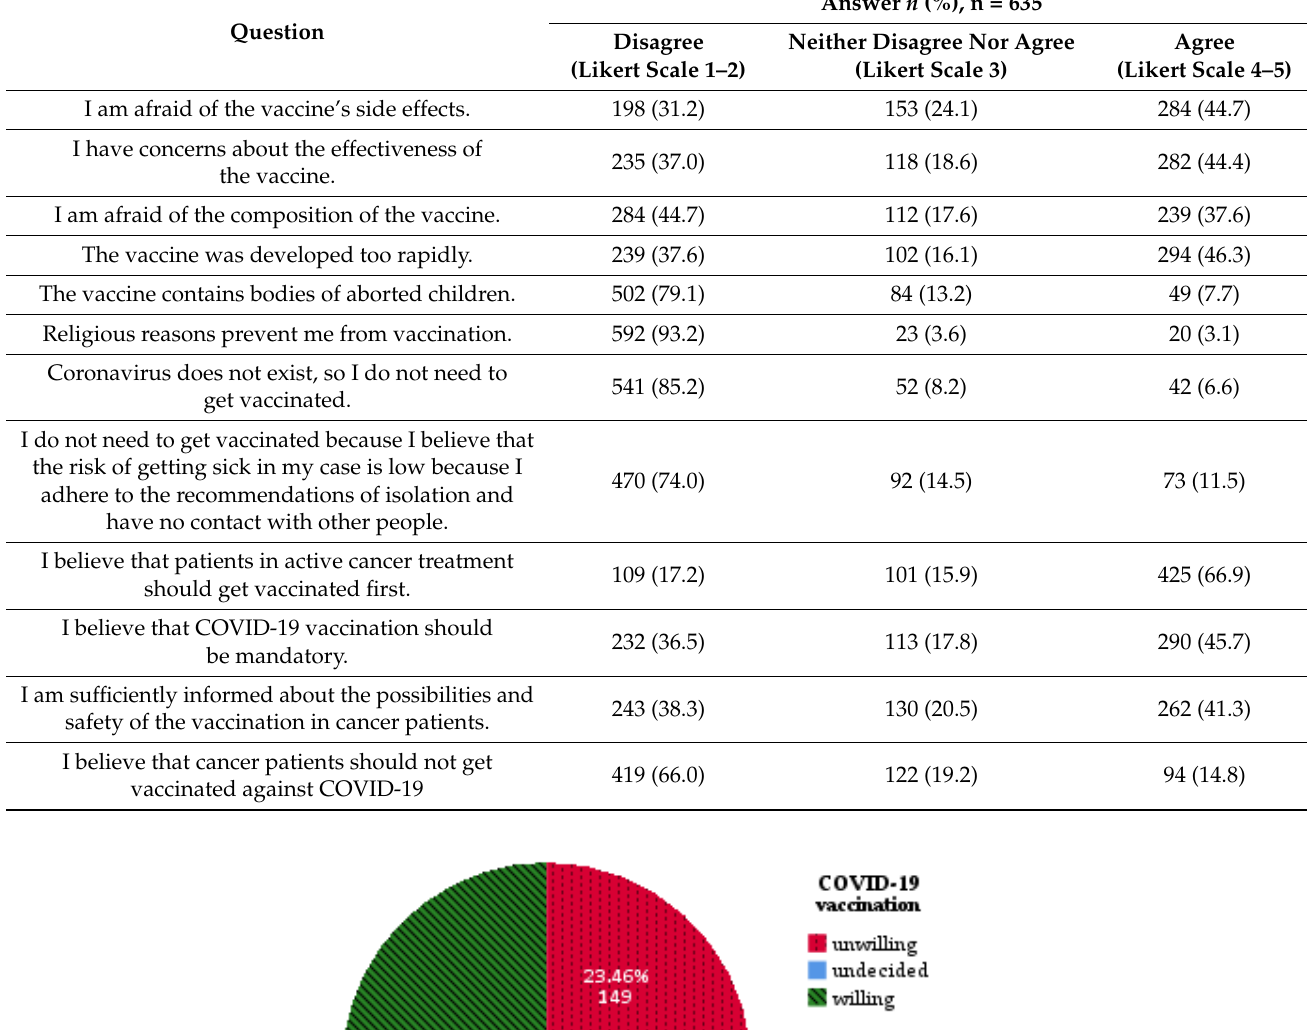
Table 4. Attitudes of patients with cancer towards COVID-19 vaccination.